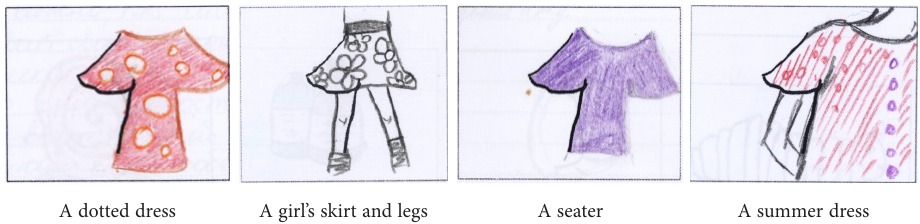
Figure 21. The creative task: interpretation of Fragment 3 – textile items (source: testingmom.com, 2020)